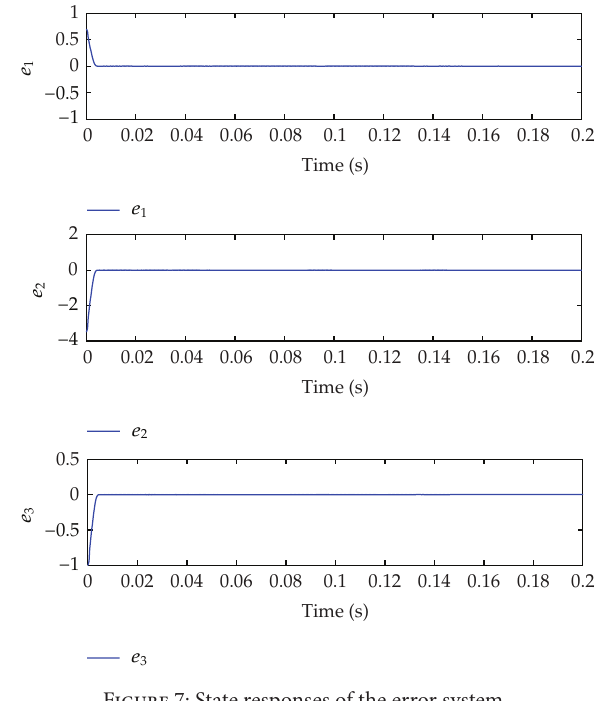
Figure 7: State responses of the error system.